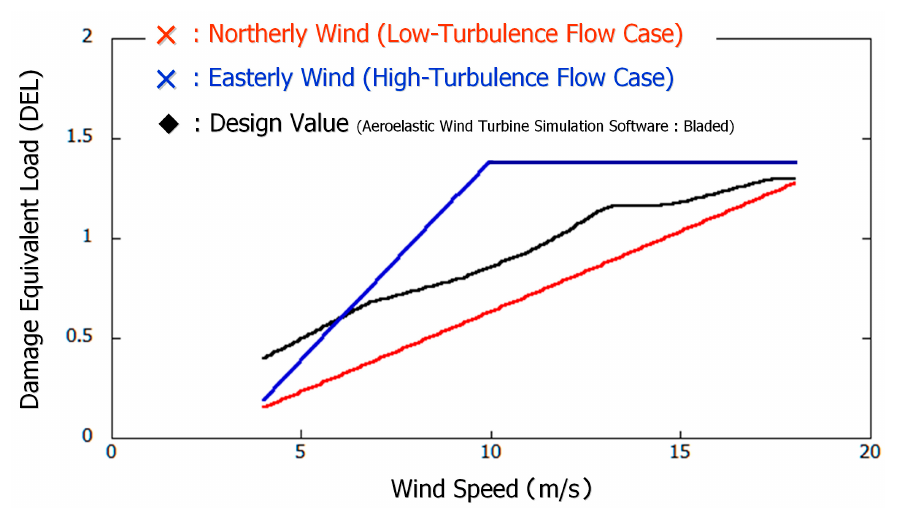
Figure 27. Regression line between wind speed (m/s) and damage equivalent load (DEL).